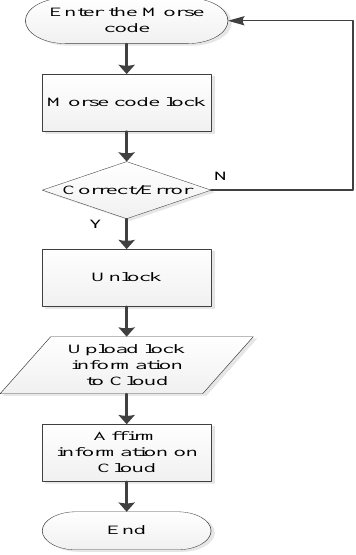
Figure 15. Flowchart for encoding/decoding and cloud monitoring.